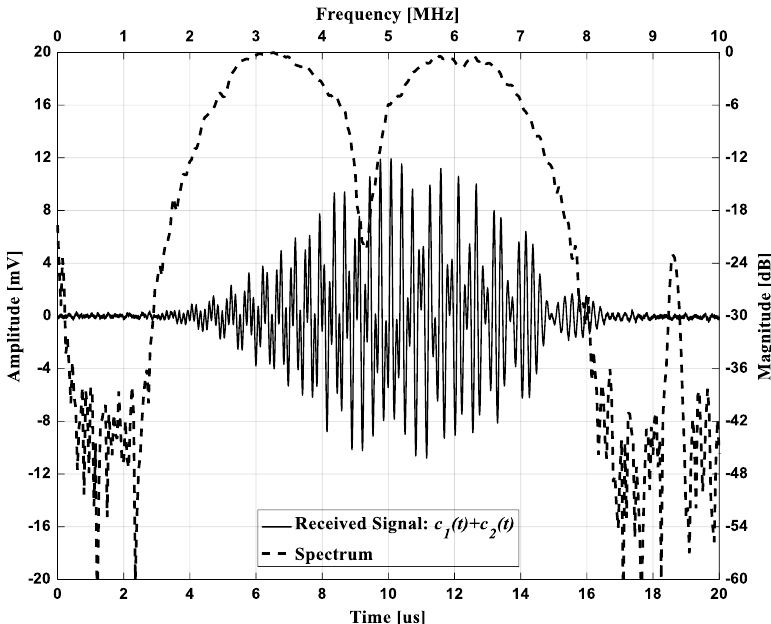
Figure 8. Time waveform of the received pulse-echo signal (solid line) after transmitting mixed two chirps c 1 ( t ) + c 2 ( t ) , and the corresponding frequency spectrum (dashed line).